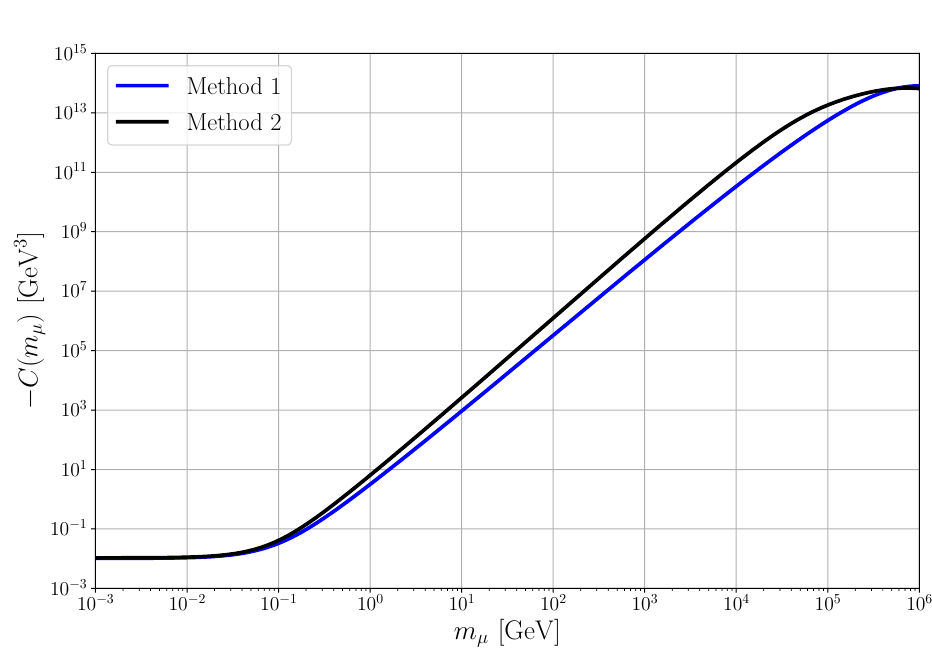
Figure 3: The order parameter of chiral symmetry breaking in the infrared, C ( m µ ) , as a function of the current quark mass, m µ , for fermions in the color triplet repre- sentation. The two different methods we use to extract this behavior (see text) are in reasonable